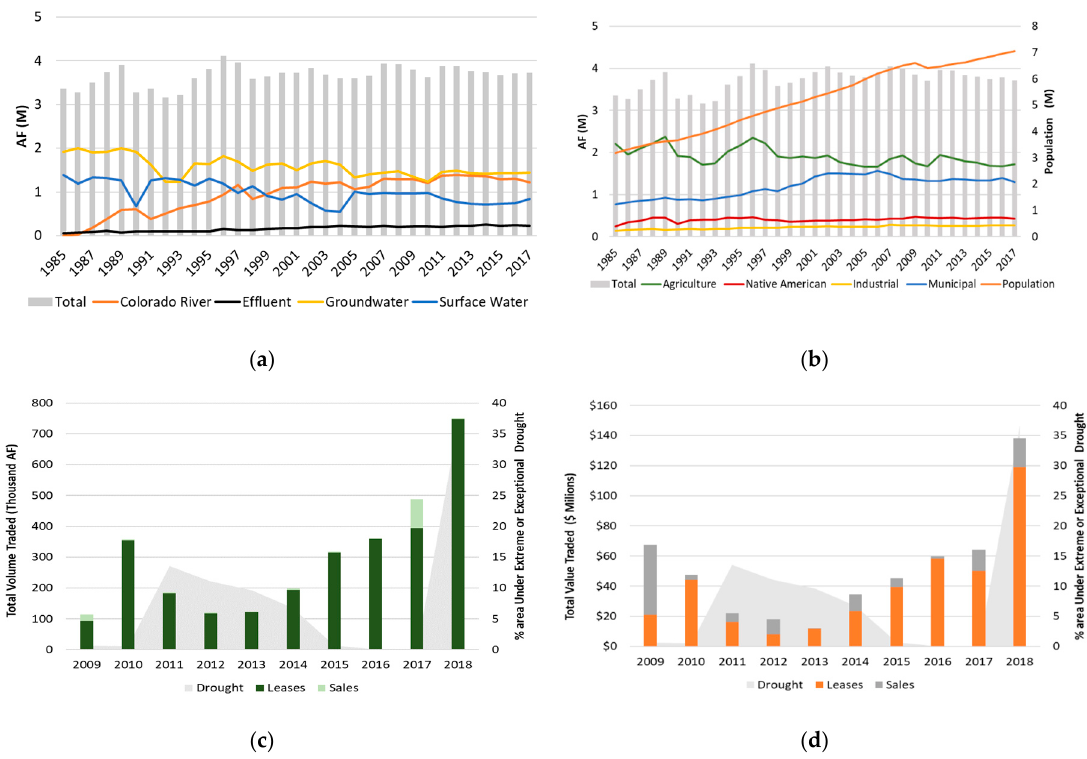
Figure 2. ( a ) Water supply by source, ( b ) water demand by sector, ( c ) total volume traded, and ( d ) total value traded in Arizona. Source: Authors calculations, Arizona Department of